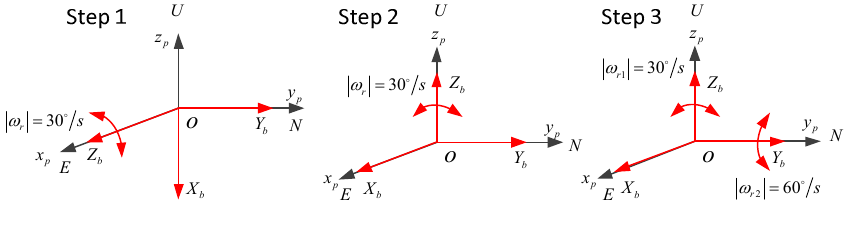
Figure 5. Three steps of the calibration.